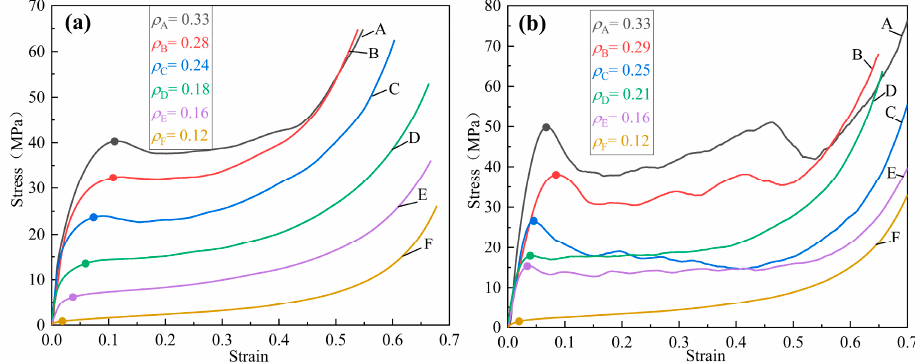
Figure 8. The stress–strain curve of the SSF samples with different relative densities: ( a ) 304; ( b ) 430.